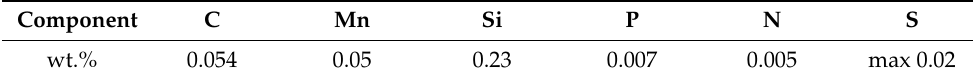
Table 3. Chemical composition of steel